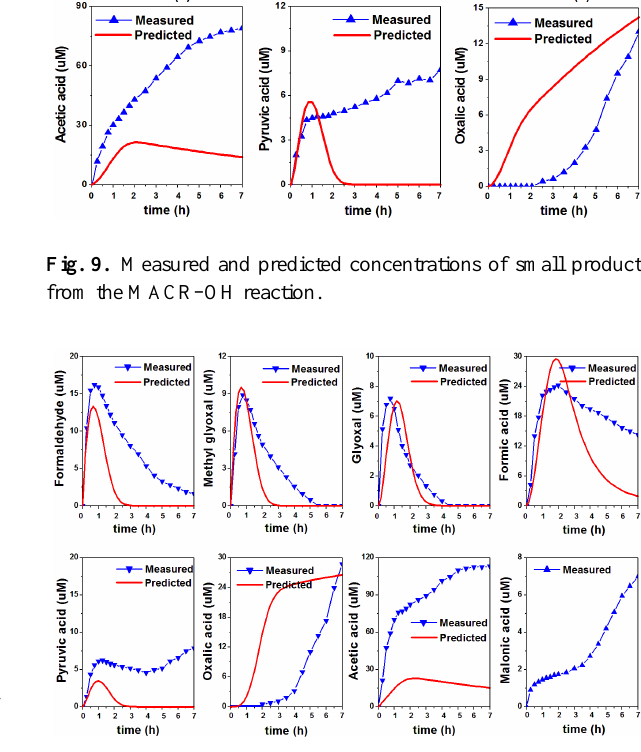
Fig. 10. Measured and predicted concentrations of small products from the MVK–OH